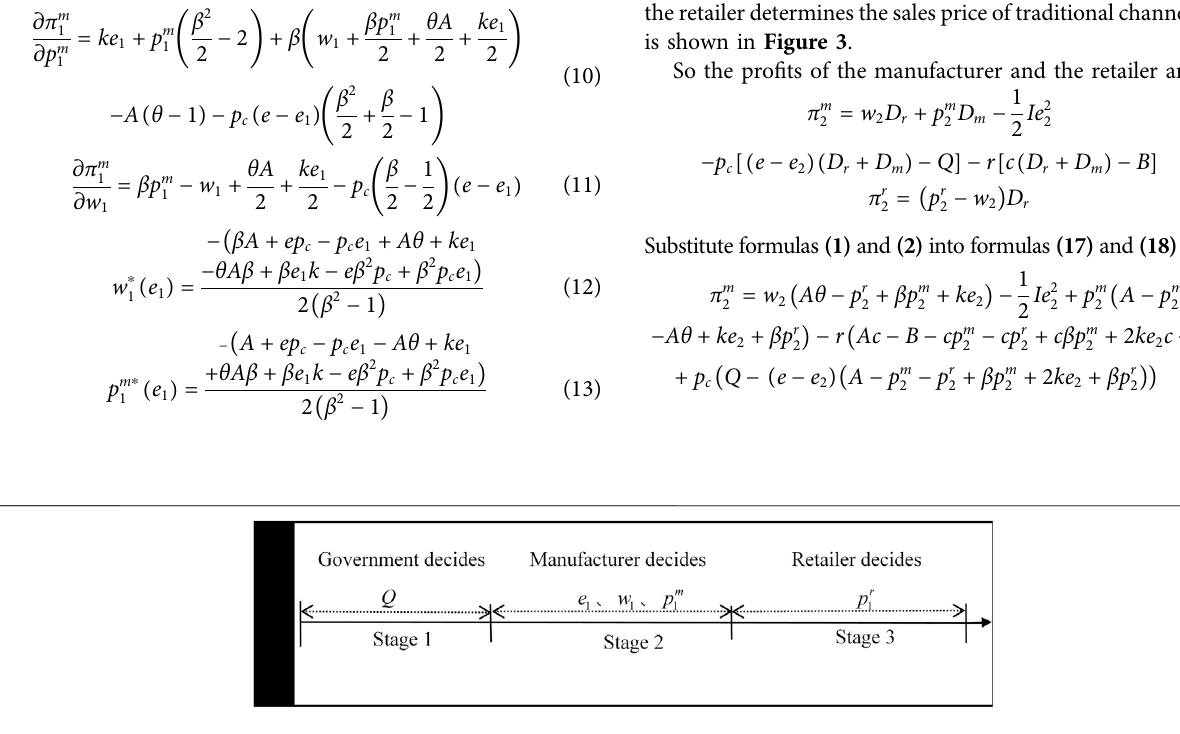
FIGURE 2 | The fi rst decision sequence diagram ecision sequence